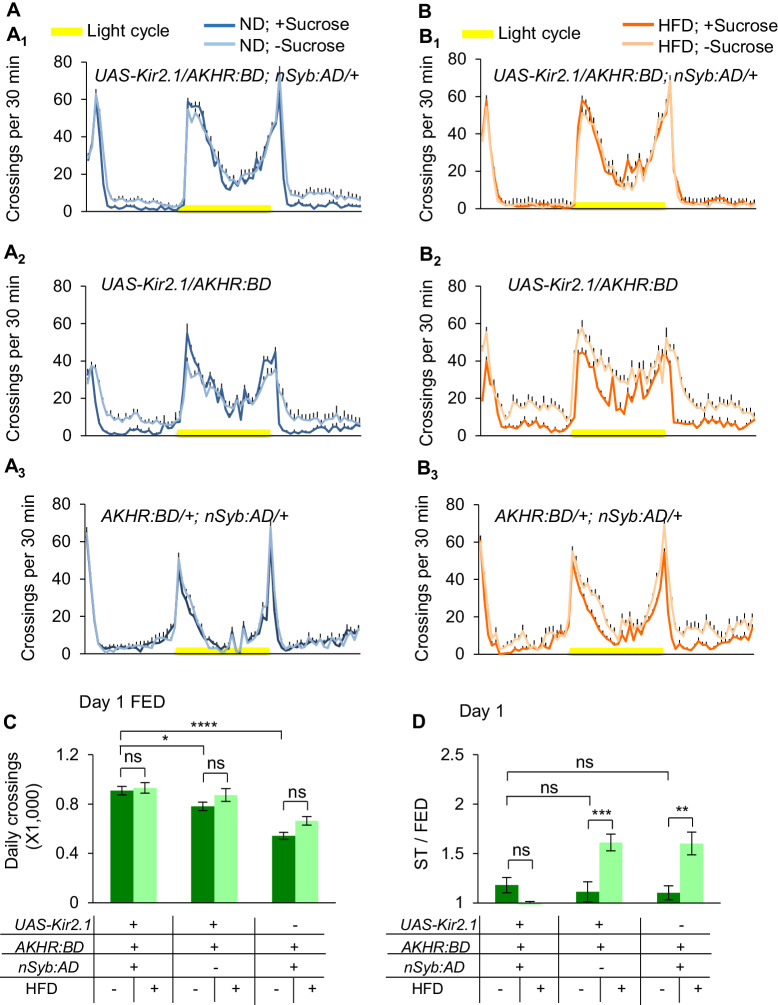
Silencing AKHR+ neurons diminishes the effect of HFD feeding to enhance starvation-induced hyperactivity.(A–B) Midline crossing activity of indicated genotypes and diet treatments assayed in the presence or absence of 5% sucrose (n = 39–64). (C) Average daily midline crossing activity of fed flies assayed in A-B. (D) Starvation-induced hyperactivity of flies assayed in A-B. ns, p>0.05; *p<0.05; **p<0.01; ***p<0.001; ****p<0.0001. One-way and two-way ANOVA followed by post hoc test with Bonferroni correction were used for multiple comparisons when applicable.